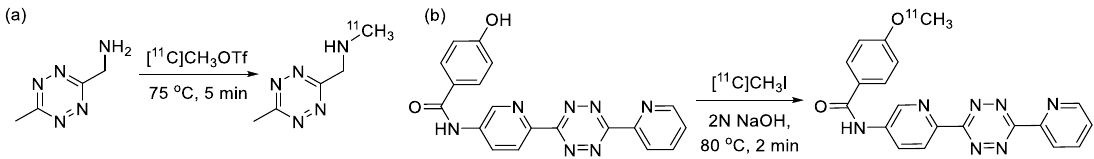
Figure 17. 11 C-labeled tetrazine tracers for in vivo IEDDA reaction, ( a ) from ref [111], ( b ) from ref